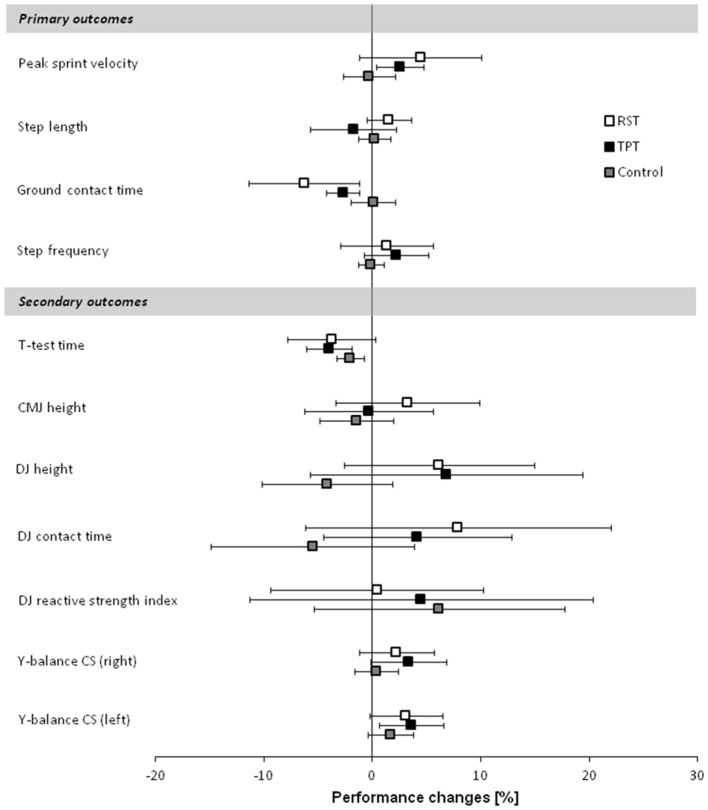
Relative pre- to post-test changes for the resisted sprint training (RST) group, traditional power training (TPT) group, and control group. Data represent mean and 90% confidence interval. CMJ, countermovement jump; CS, composite score; DJ, drop jump; RST, resisted sprint training; TPT, traditional power training.